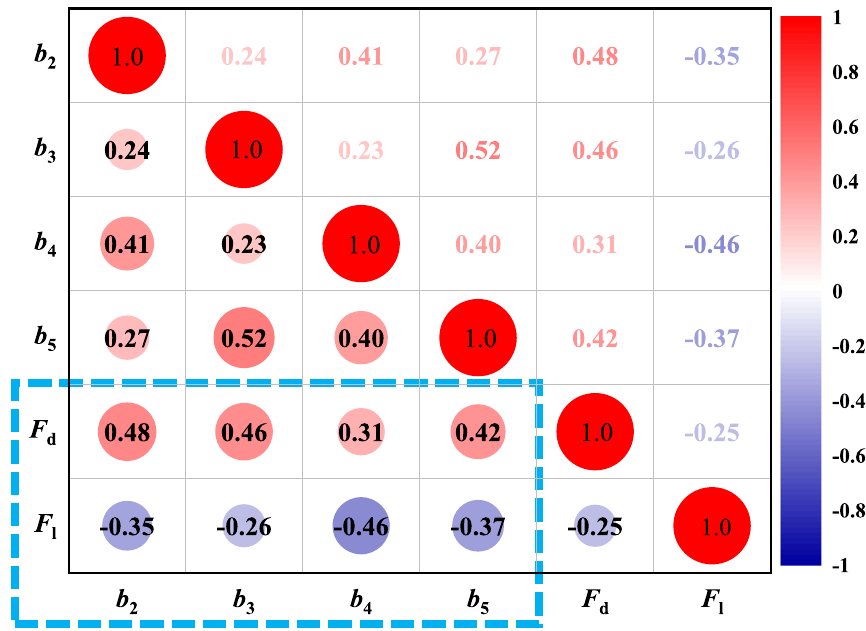
Fig. 14 The correlation of design variables and optimization objectives